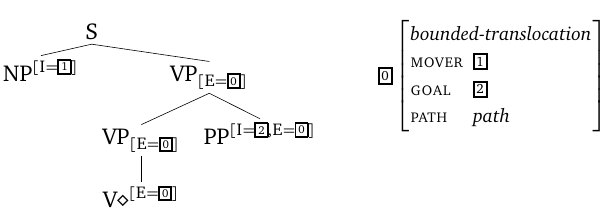
Figure 17: Unanchored tree and semantics of n0Vpp(dir)